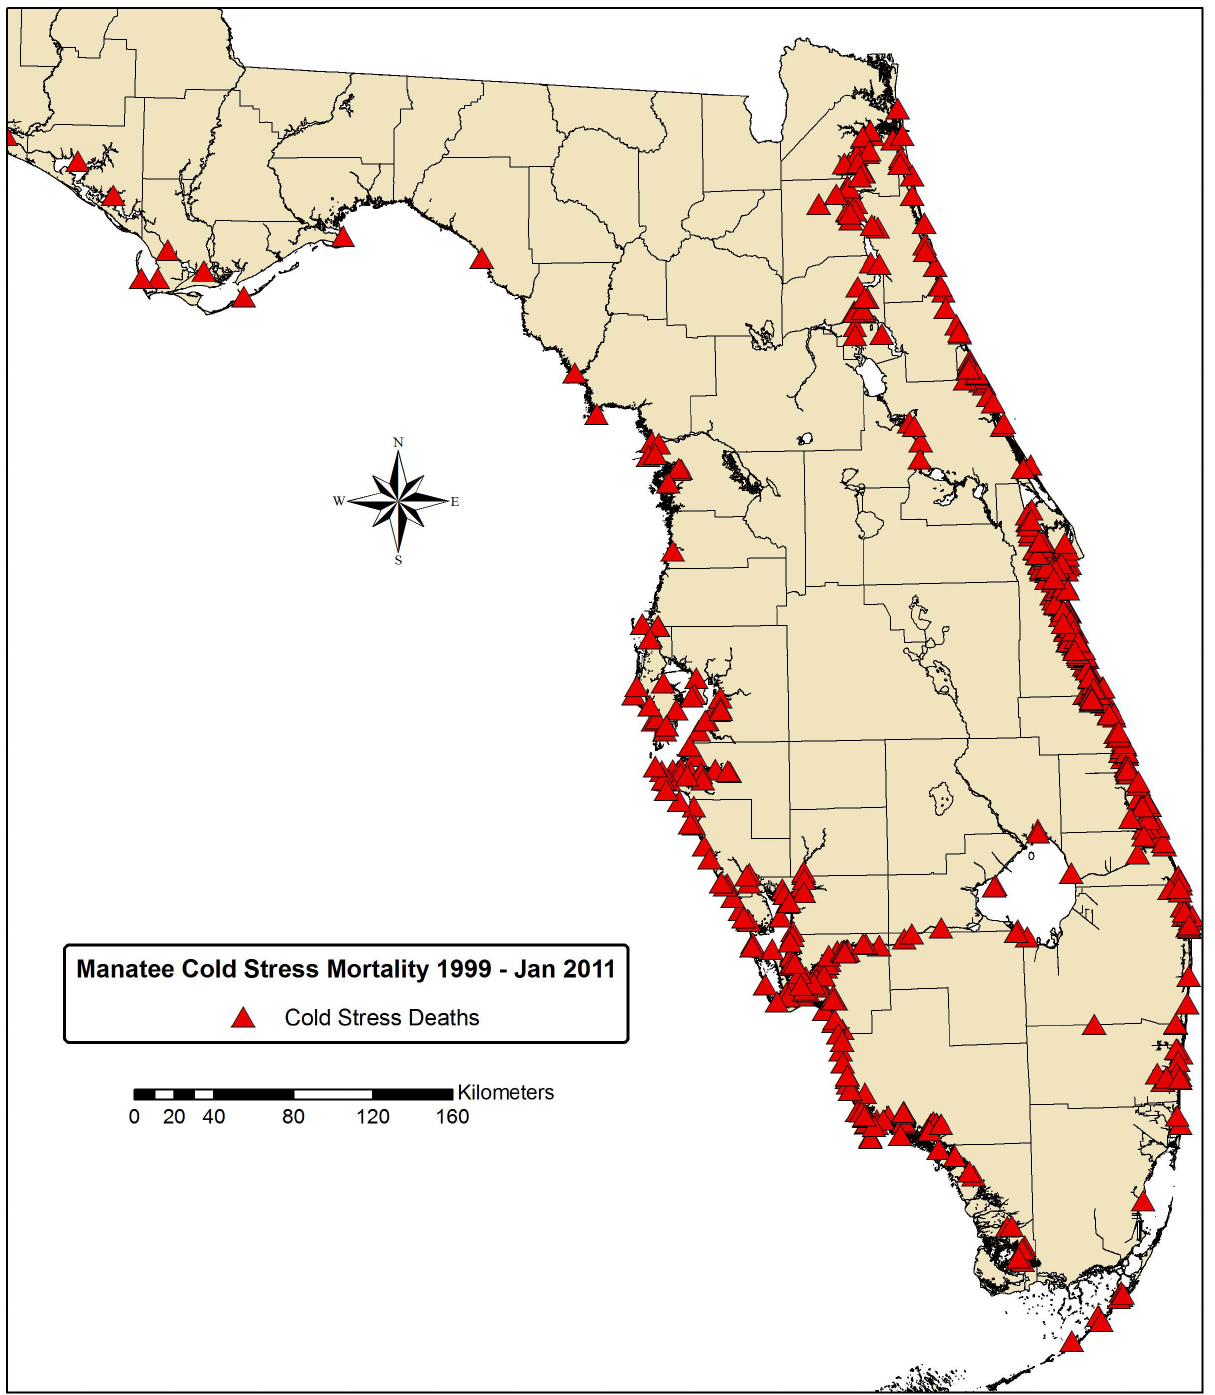
Figure 6. Location of manatee deaths attributed to cold stress, 1999 – 2011. doi:10.1371/journal.pone.0058978.g006 half of the area used by most of the region’s overwintering animals. Power plants and a few PTBs provide this area’s only warm-water refuges. The other area with high numbers of cold-stress deaths was the southern part of the Southwest Florida region, where 25.4% (n= 181) of all such deaths were recovered and where high numbers of suspected but unverified cold-stress deaths also occurred (i.e., Lee, Collier, and Monroe counties). Power plants